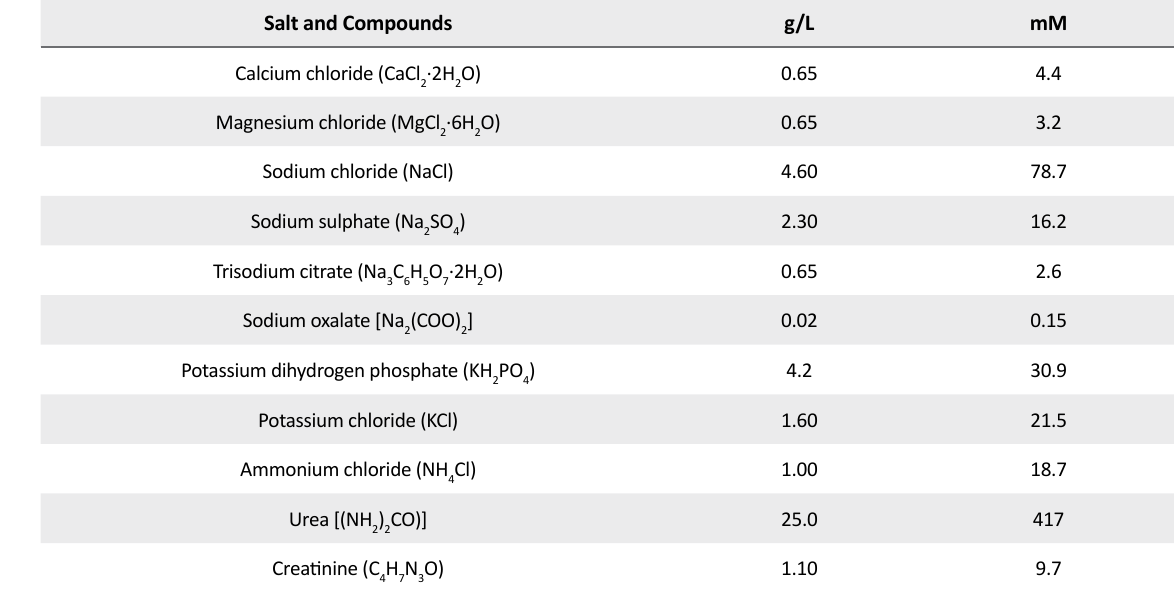
Table 1. Composition of the synthetic urine Salt and Compounds